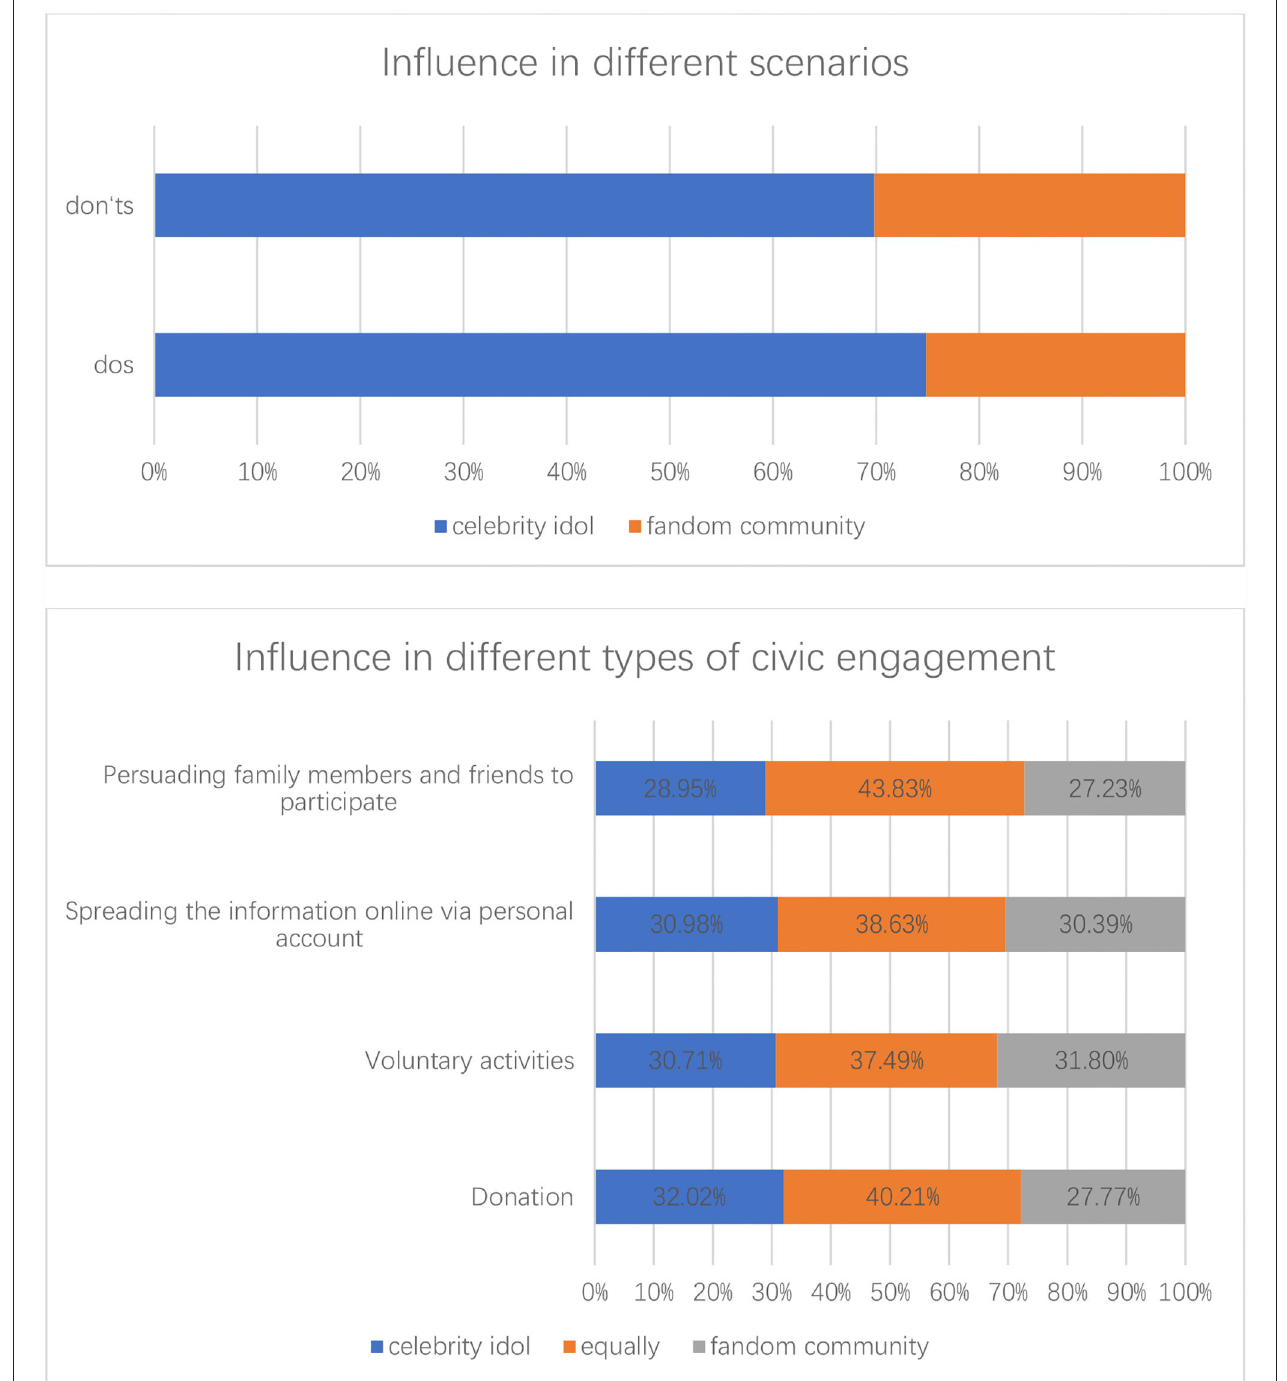
FIGURE 9 | Influence of celebrity idol and fandom community in different scenarios and different types of civic